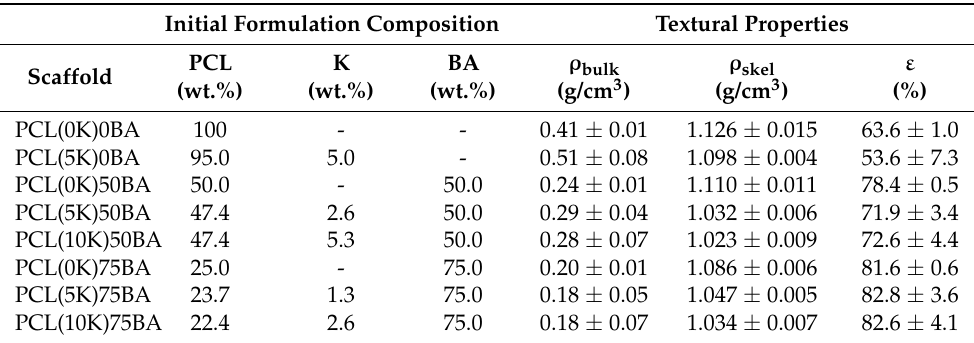
Table 1. Composition (expressed in weight percentage) of the initial mixtures used for the scaffold formulations and textural properties of the resulting macroporous ketoprofen-loaded PCL scaffolds by sc-foaming combined with BA porogen leaching. Initial Formulation